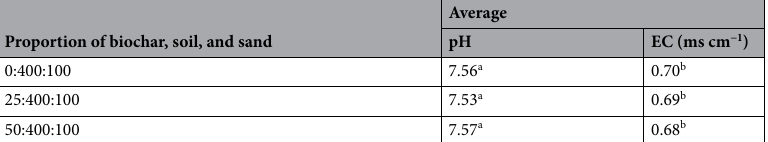
Average pH EC (ms cm −1 )